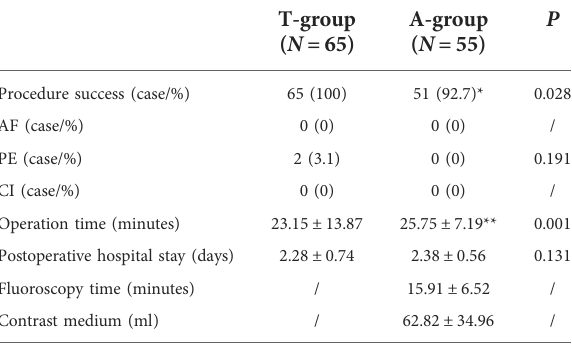
TABLE 2 Procedural characteristics.